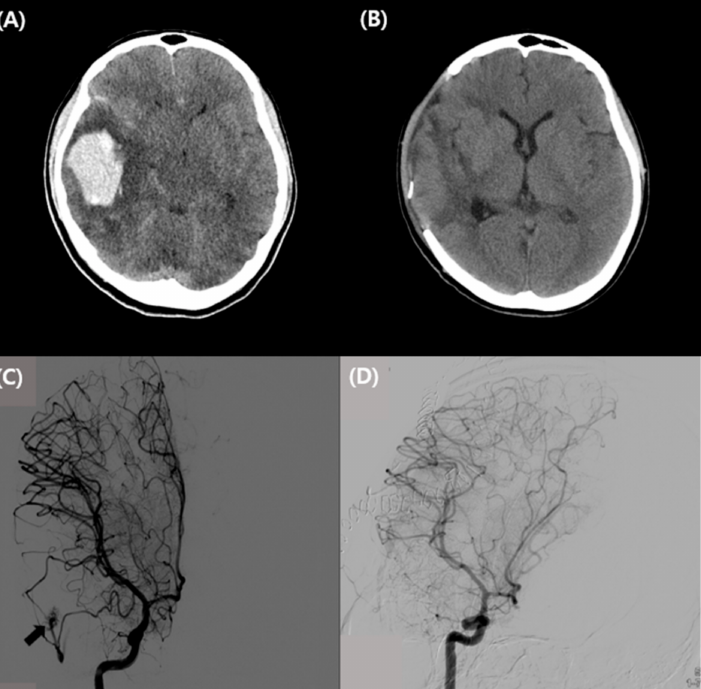
Figure 1. Initial and post-operative brain CT and TFCA images in the patient. ( A ) Preoperative axial image on non-enhanced brain CT, showing a 5.0 × 3.7 × 5.0 cm 3 -sized intracranial hemorrhage in the right temporal lobe with perilesional edema and mass effect with mild left side midline deviation. ( B ) Postoperative non-enhanced brain CT image 30 days after craniectomy showing marked resolution of a residual hematoma in the right cerebral hemisphere and improvements in perilesional edema and mass effect. ( C ) Preoperative TFCA showing that blood was supplied to the brain AVM by the right middle cerebral artery branch and drained into the right transverse sinus (arrow). ( D ) Post-operative TFCA 30 days after craniectomy showing removal of the AVM nidus and no residual shunt flow. Abbreviations: CT, computed tomography; TFCA, transfemoral cerebral angiography; and AVM, arteriovenous